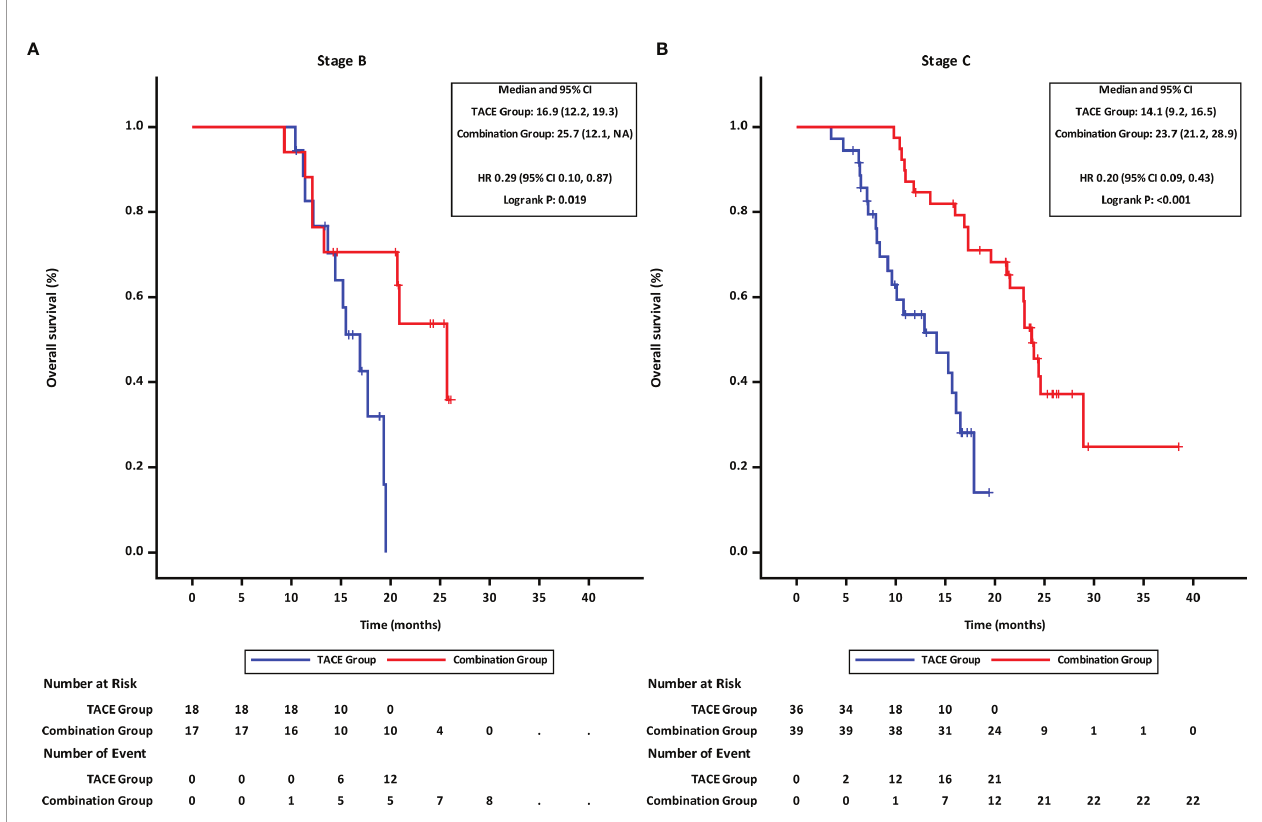
FIGURE 5 | Overall survival of groups of patients at different BCLC stages. (A) BCLC stage B, (B) BCLC stage C TACE, transcatheter arterial chemoembolization; PD-1, programmed cell death-1; BCLC, Barcelona Clinic Liver Cancer; HR, hazard ratio; CI, con fi dence interval.